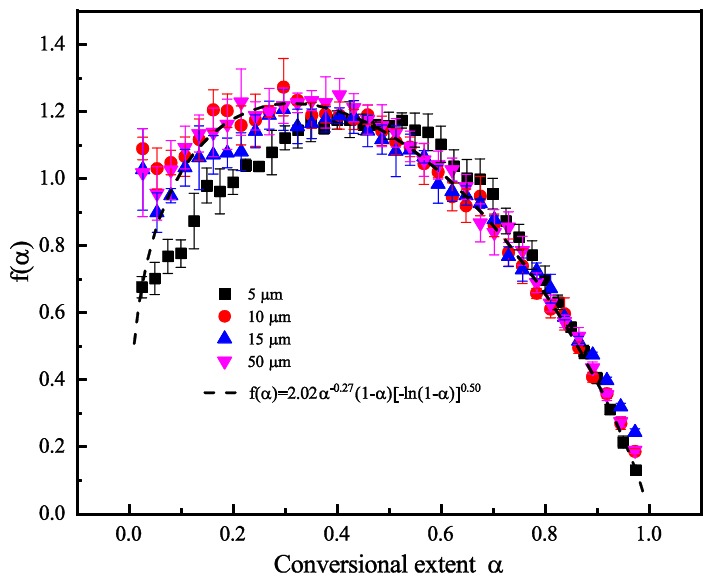
Figure 6. The experimental kinetics function f ( α ) reconstructed for 5, 10, 15, and 50 µ m sample size.